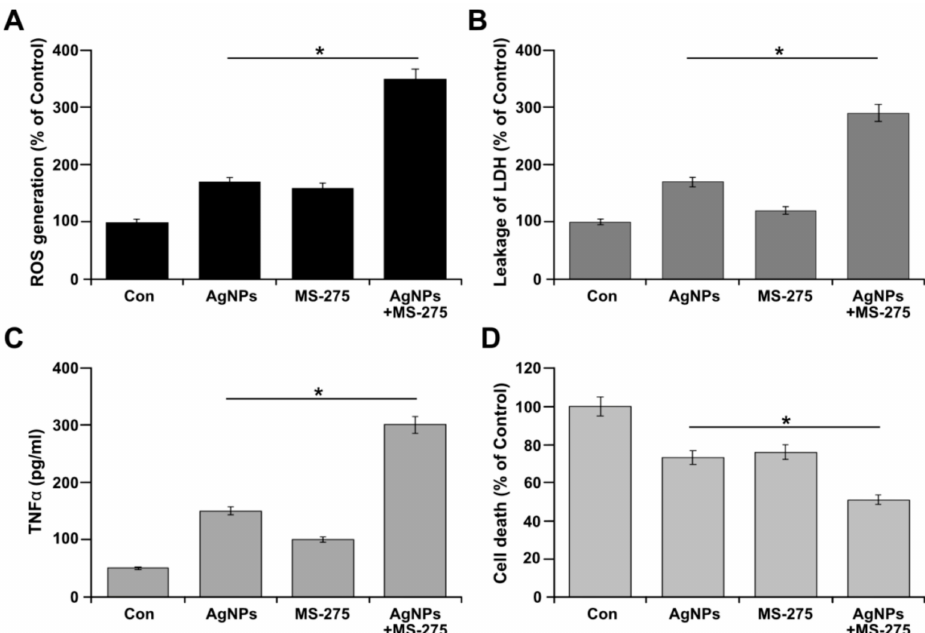
Figure 5. AgNPs and MS-275 induce cytotoxicity. A549 cells were incubated with AgNPs (1 µ M), MS-275 (1 µ M), or a combination of AgNPs (1 µ M) and MS-275 (1 µ M) for 24 h. ( A ) The levels of reactive oxygen species (ROS) were assessed by measuring the relative fluorescence of 2 (cid:48) ,7 (cid:48) -dichlorofluorescein using a spectrofluorometer. ( B ) The activity of lactate dehydrogenase (LDH) was measured at 490 nm using the LDH cytotoxicity kit. ( C ) Measurement of induction of TNF α . ( D ) The level of dead-cell protease was determined by CytoTox-Glo cytotoxicity assay. The results are expressed as the mean ± standard deviation of three independent experiments. Statistically significant differences between the treated and control group are indicated by (* p <